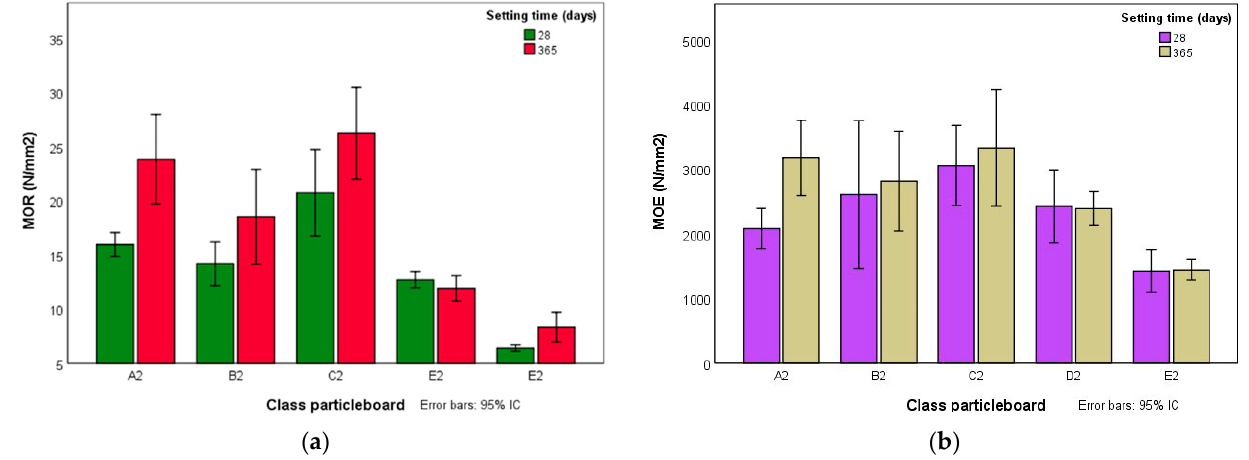
Figure 7. ( a ) Modulus of rupture (MOR) and ( b ) modulus of elasticity (MOE) after 28 and 365 days of cement hydration.